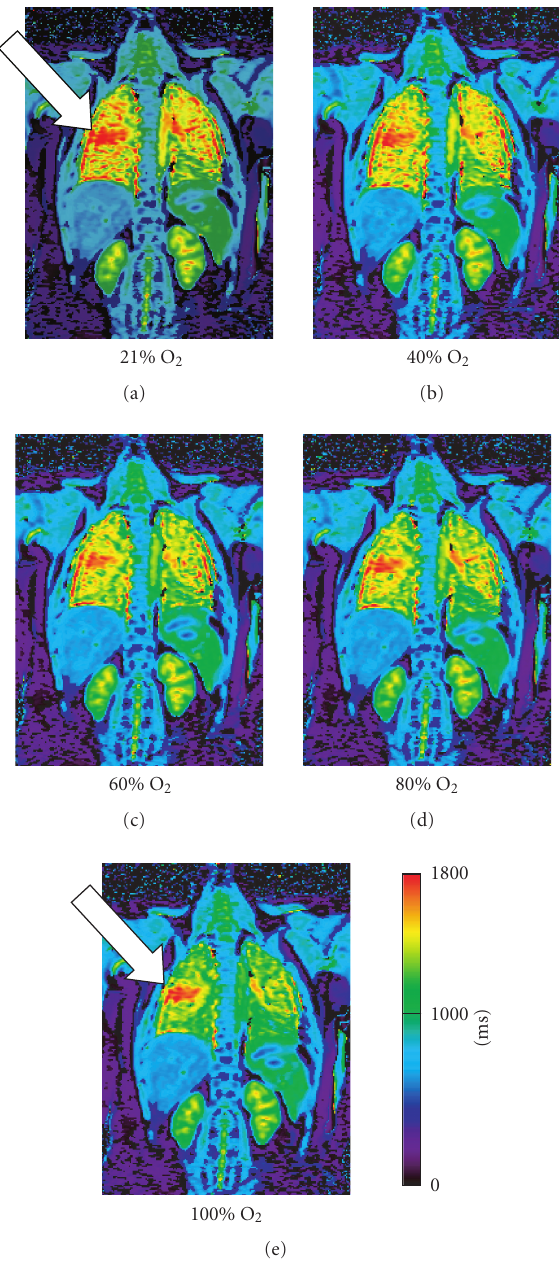
Figure 7: T1 map (millisecond) of a patient with Cystic Fibrosis: in- halation of increasing oxygen concentrations demonstrates a steady shortening of T1 times in the healthy lung segments. The diseased tissue of the right mid lobe (arrow) distinguishes itself in that the T1 time remains relatively